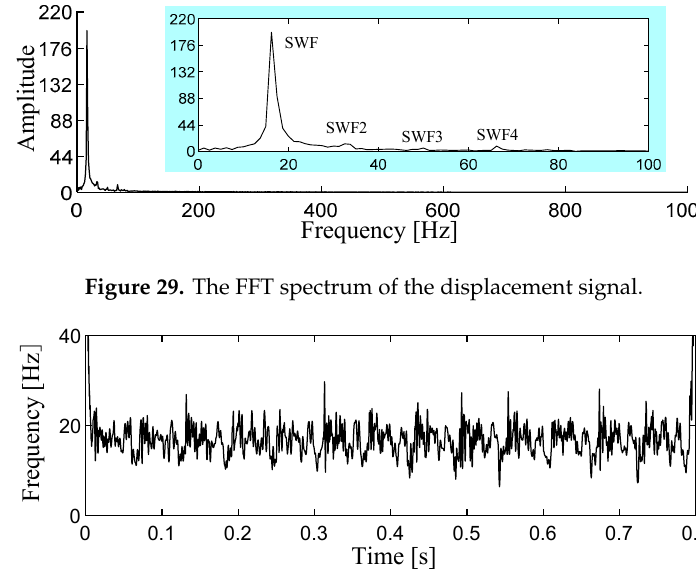
Figure 30. The IF curve of the displacement signal.